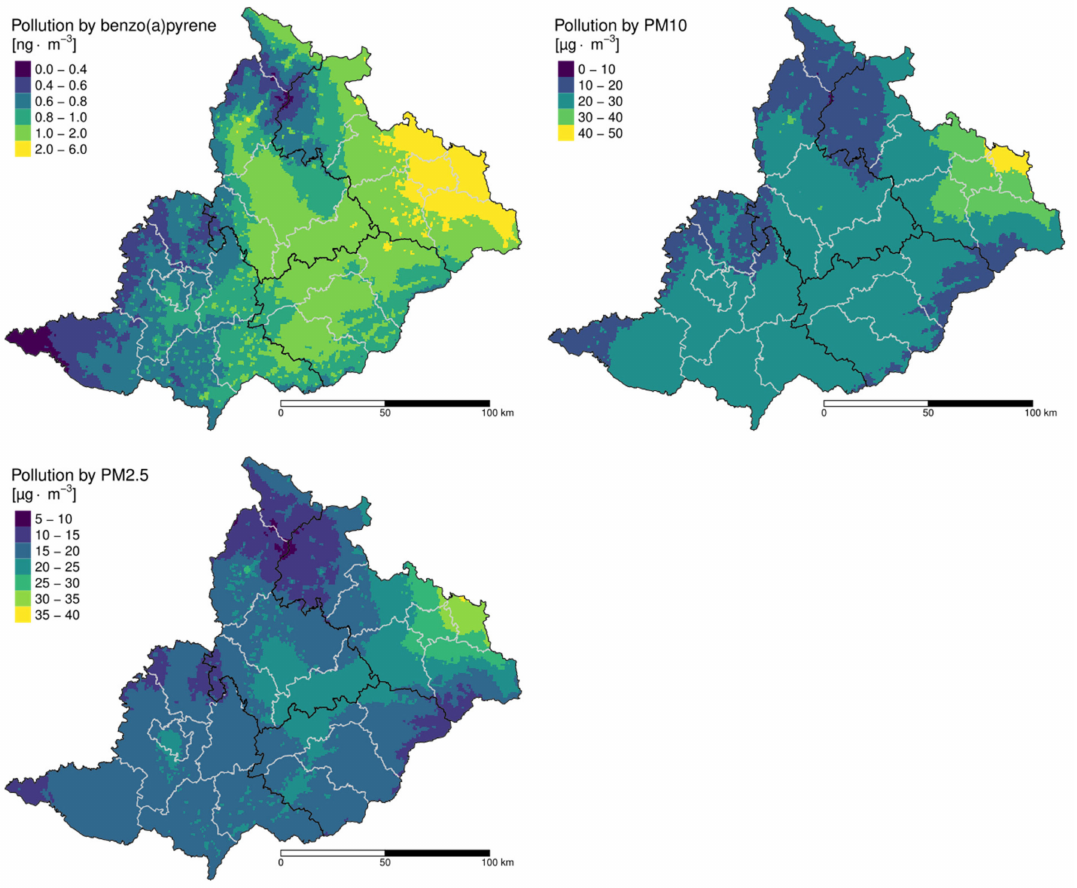
Figure A1. Five-year (2012–2016) average concentrations of benzo[a]pyrene, PM 10 and PM 2.5 in the air in the studied regions based on the data from the Czech Hydrometeorological Institute